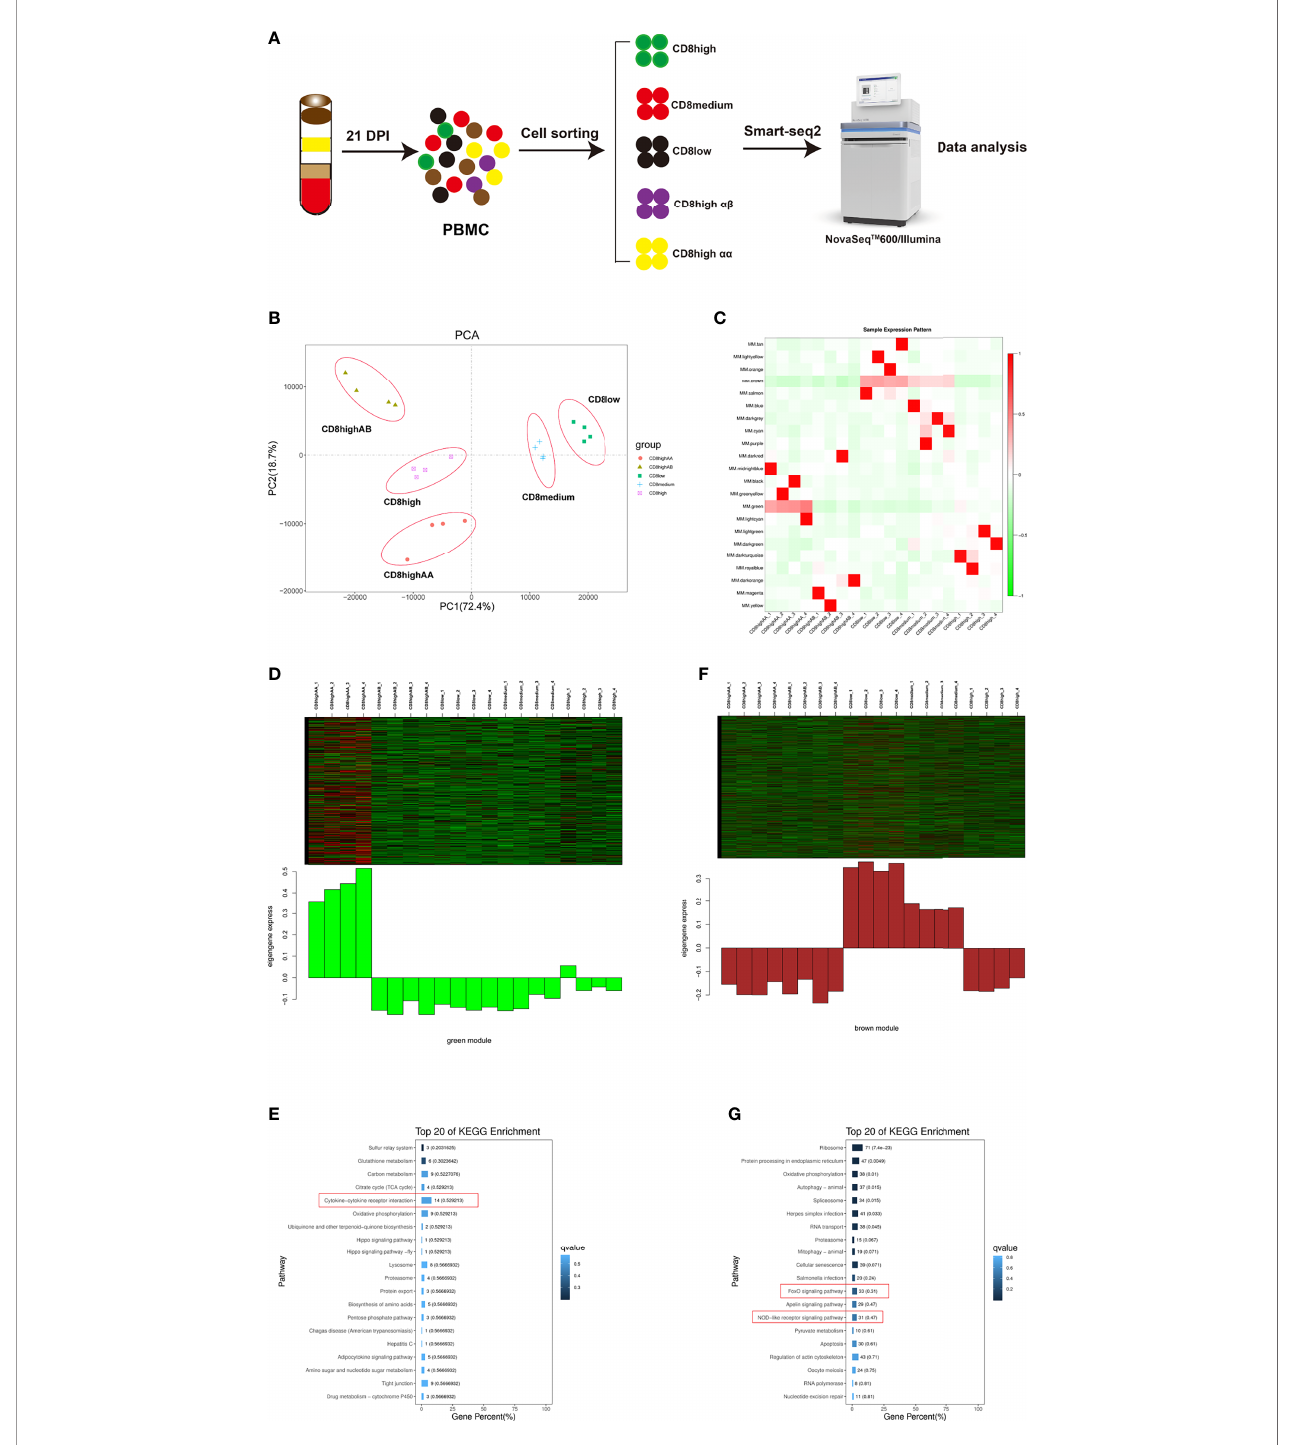
FIGURE 1 | WGCNA analysis of CD4 + CD8 low+ (CD8 low+ ), CD8 medium+ , CD8 high+ , CD8 high aa + , and CD8 high ab + T cell populations in PBMCs from ALV-J infected chicken at 21 days post-infection. (A) Schematic outline of the study design. (B) PCA analysis of the fi ve T cell populations, each with four replications. The X- and Y-axis show the principal component 1 and component 2, which explains 72.4% and 18.7% of the total variance. (C) The heat map of sample expression pattern. Red indicates high expression. Green indicates low expression. (D) Heat map of the gene expression pattern of the green module. (E) Top 20 KEGG pathways selected for green module gene enrichment. (F) Heat map of the gene expression pattern of the brown module. (G) Top 20 KEGG pathways selected for brown module gene